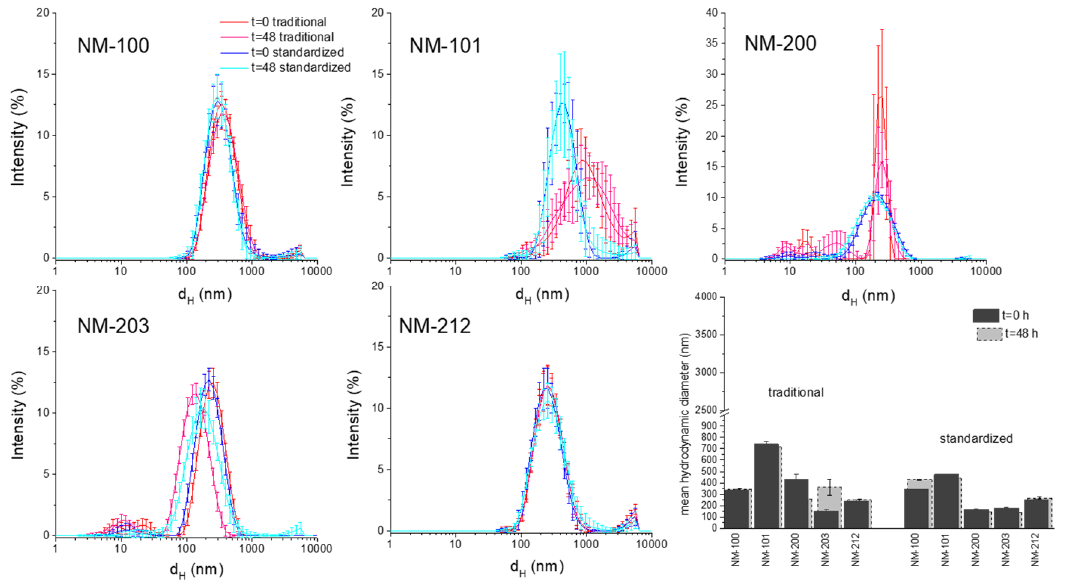
Figure 6. DLS analysis of the NM in DMEM at 100 µg/mL at t = 0 and t = 48 h. The panels represent for each sample the comparison between the suspensions prepared by the traditional protocol and those prepared by the standardized protocol. In the last panel, the mean Z D ± SD are reported. Data are the mean of 30 measurements.